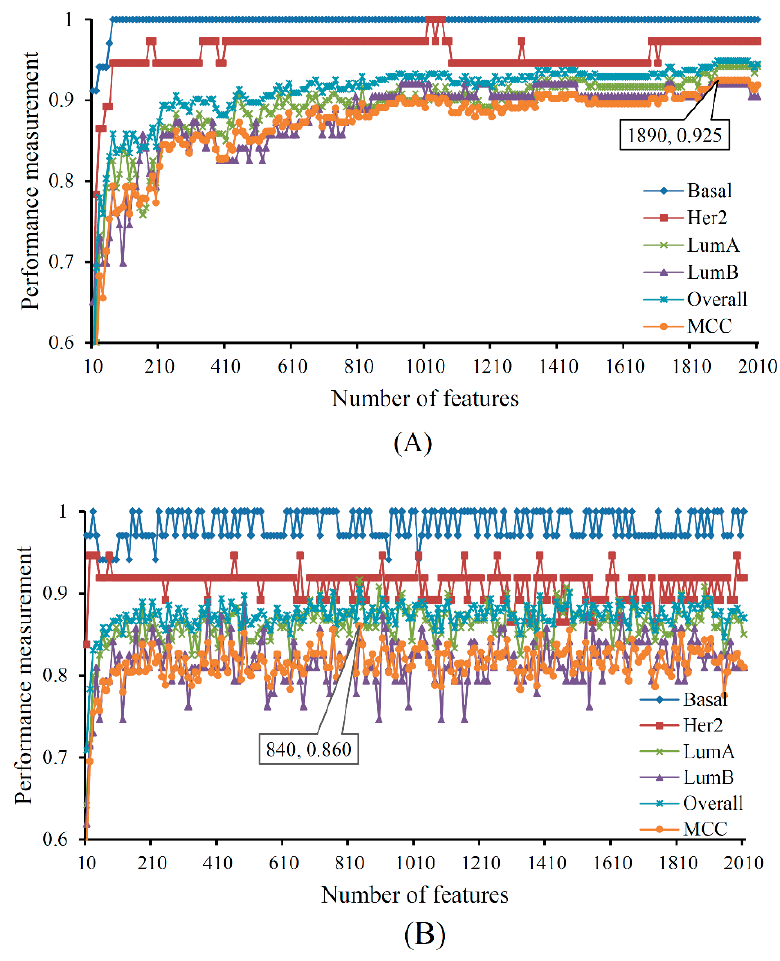
Figure 2. The performance of support vector machine (SVM) and random forest (RF) change with the number of features. ( A ) The performance of SVM; ( B ) The performance of RF.